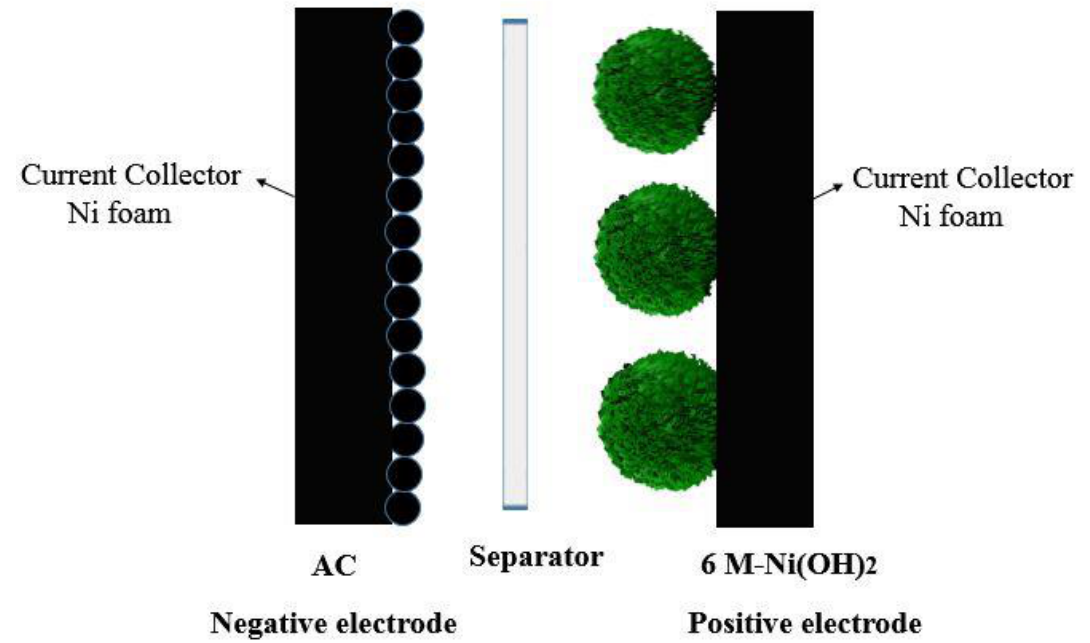
Figure 10. Schematic diagram of the 6 M-Ni(OH) 2 // AC hybrid supercapacitor (HSC).